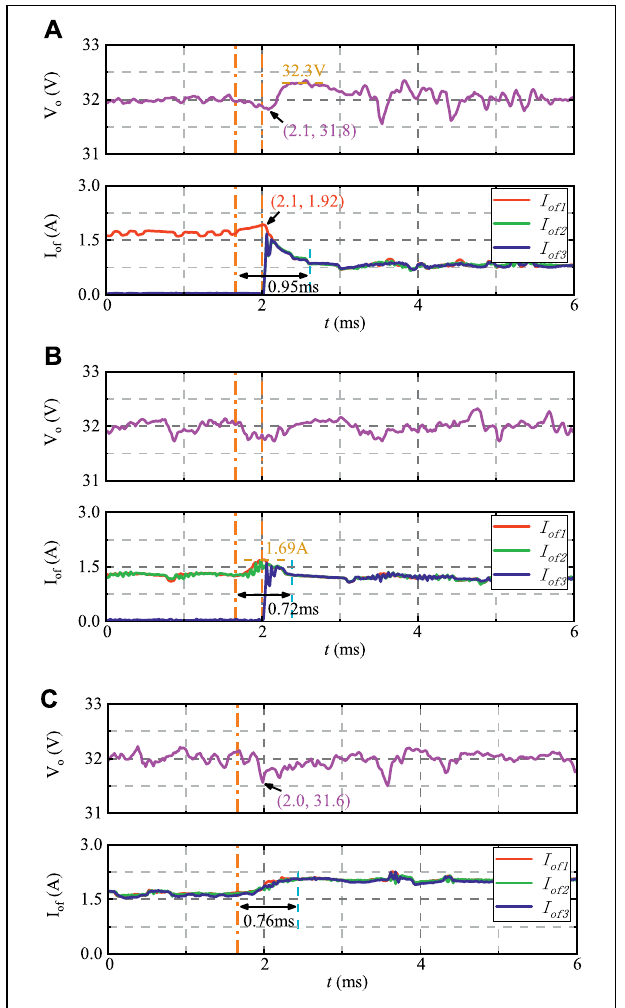
FIGURE 11 | Experimental waveforms of the step load response: (A) from 60 to 90-W step load change with single-phase scheme, (B) from 90 to 130-W step load change with two-phase load-sharing scheme, and (C) from 180 to 220-W step load change with three-phase load-sharing scheme.